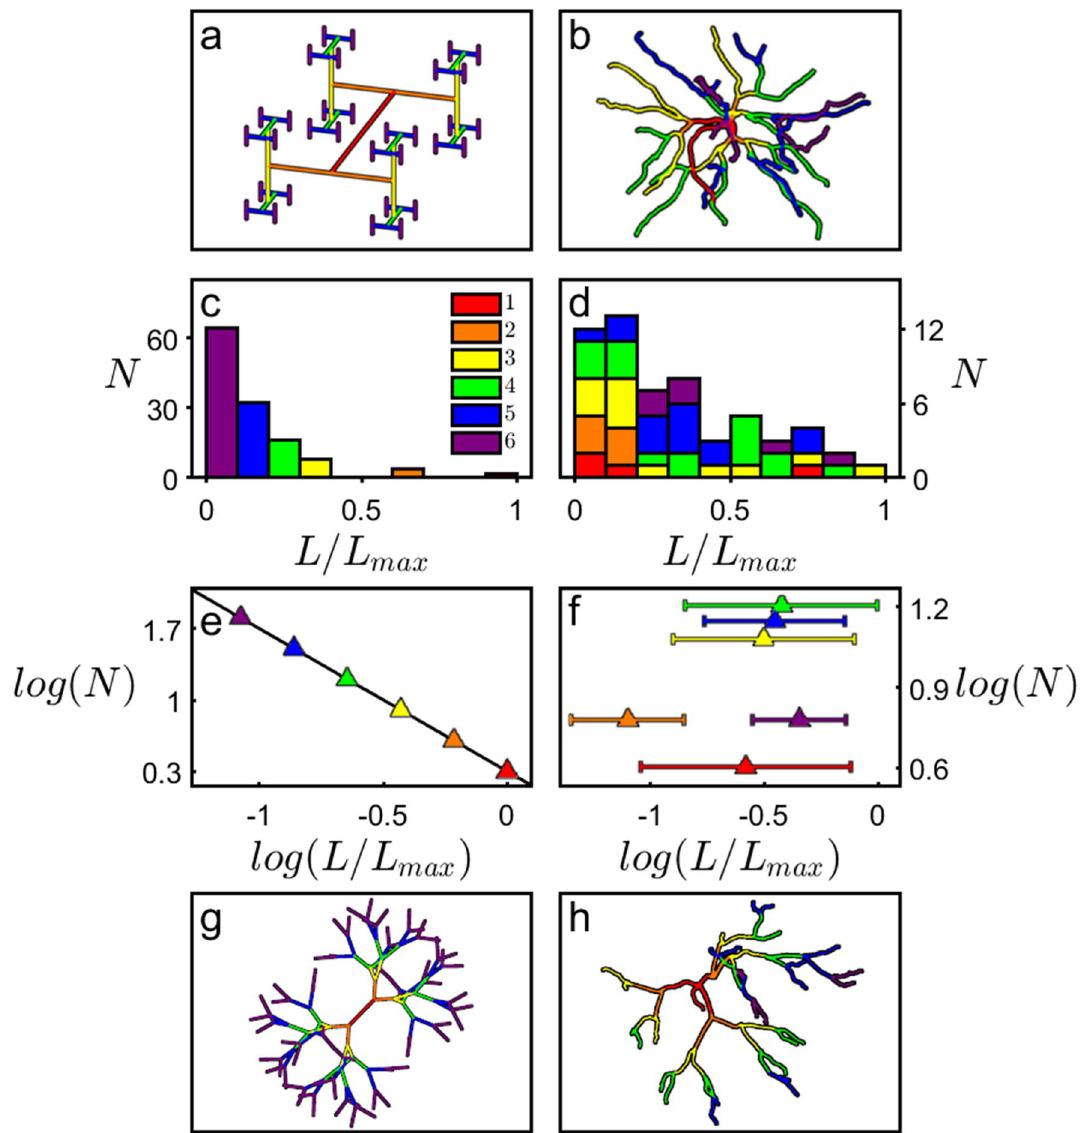
Figure 2. A D = 1.4 H-Tree fractal (generated using Mathematica and displayed using MATLAB) with W = 1 μm ( a ) and an example neuron’s basal arbor (reconstructed using Neurolucida and displayed using MATLAB) with median W = 1.4 μm ( b ). The branch level i is colored as follows: red (1st branch), orange (2nd), yellow (3rd), green (4th), blue (5th), and purple (6th). Histograms for an H-Tree ( c ) and neuron ( d ) plotting the number of branches N with a given value of L/L max . Panels ( e ) and ( f ) show the analysis of ( c ) and ( d ) plotted in log–log space. Panels ( g ) and ( h ) take the H-Tree and neuron shown in ( a ) and ( b ) and adjust all their branch lengths to be equal. Additionally, the H-Tree’s forking angle has been adjusted to 37° (the median value of the basal ϕ